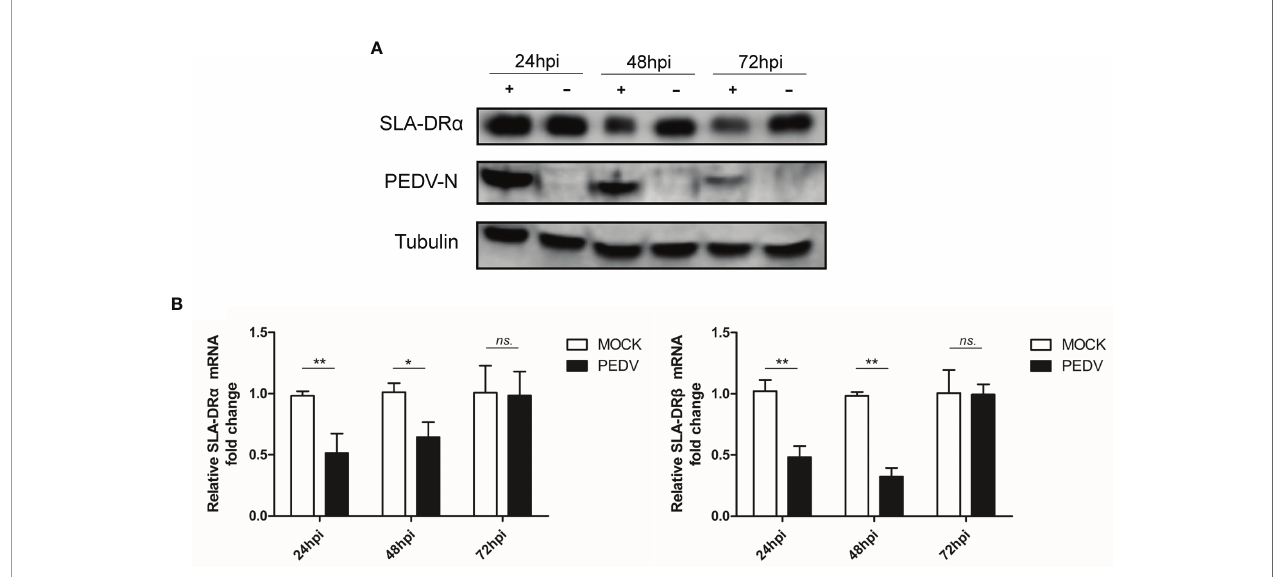
FIGURE 5 | PAMs are susceptible for PEDV. (A) PAMs were infected by Vero cell-adapted PEDV strain KB2013-p120 for 24, 48 and 72 hours. Next, cells were harvested for western blot using mice serum raised against recombinant PEDV-N protein and anti-SLA-DR a Mab. Normal PAMs cells without PEDV infection were included as control. Tubulin was probed from the same sample to normalize the total protein load. (B) PAMs were infected by PEDV strain KB2013-p120 for 24, 48 and 72 hours. Next, cells were harvested by TRizol for qPCR analysis of SLA-DR a and b mRNA level. Normal PAMs cells without PEDV infection were included as control. Error bars represent variation from at least three independent experiments. Signi fi cant differences between indicated groups was marked by * P < 0.05; ** P < 0.01. or ns, non signi fi